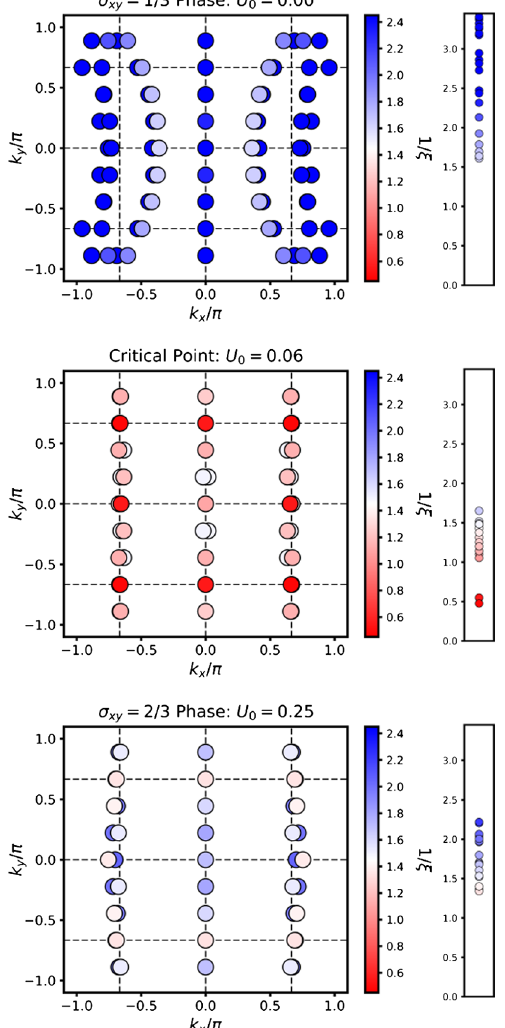
FIG. 5. Correlation length spectra of operators carrying zero ⃗ k electric chargeversuscrystal momenta in three different regimes: (i) σ xy ¼ 1 = 3 FQH phase; (ii) critical point; (iii) σ xy ¼ 2 = 3 FCI phase. The spectrum is obtained from simulations with DMRG bond dimension χ ¼ 6000 . The color bar represents the inverse of correlation length 1 = ξ . Note that we have a finite circumference size L y ¼ 9 in the units of the lattice constant, so the k y take discretized values k y ¼ 2 π n=L y , n ¼ 0 ; 1 ; … L y − 1 . At the criti- cal point, the correlation lengths at the eight momenta ð k x ; k y Þ ¼ ð 2 π n x = 3 ; 2 π n y = 3 Þ ≠ 0 are the largest and identical. These modes correspond to the eight SU(3) adjoint mass terms. Numerically, correlation lengths at other k -points have at least twice smaller correlation lengths in this data. The spectra at the σ xy ¼ 1 = 3 and 2 = 3 phases have no additional symmetries other than two reflections ( k x and k y ) and approximate C 4 rotation inherent to the simulation. At σ xy ¼ 2 = 3 , one may notice that there are also eight points with almost identical correlation lengths near the aforementioned eight special momenta. However, (i) they deviate from the exact momenta of SU(3) adjoint mass terms, and (ii) their correlation lengths are not well separated from correlation lengths of other k -points, e.g., ð k x ; k y Þ ∼ ð(cid:5) 2 π = 3 ; (cid:5) 4 π = 9 Þ